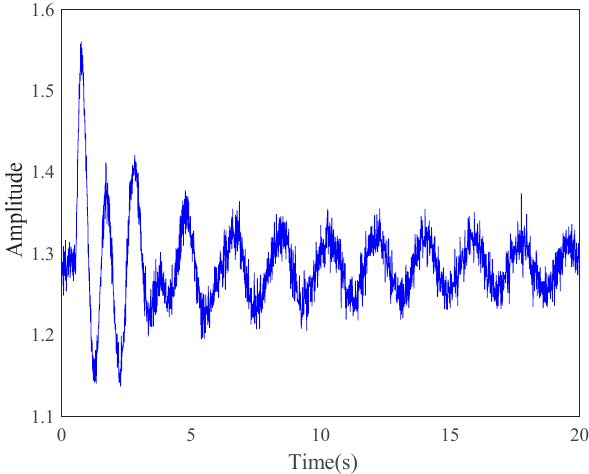
Figure 14. Real-time signal in the power system.